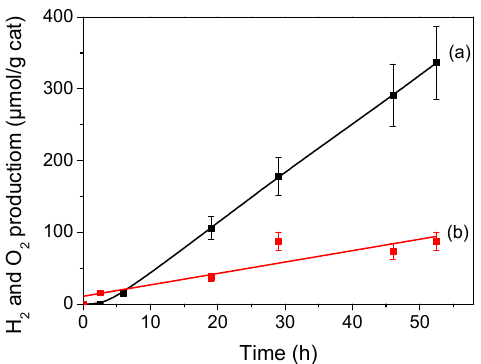
Figure 4. Temporal hydrogen ( a ) and oxygen ( b ) evolution upon simulated sunlight irradiation (100 mW cm − 2 ) of MA 2 CuCl 2 Br 2 films exposed to a H 2 O-satured atmosphere at 1 atm and 40 °C.